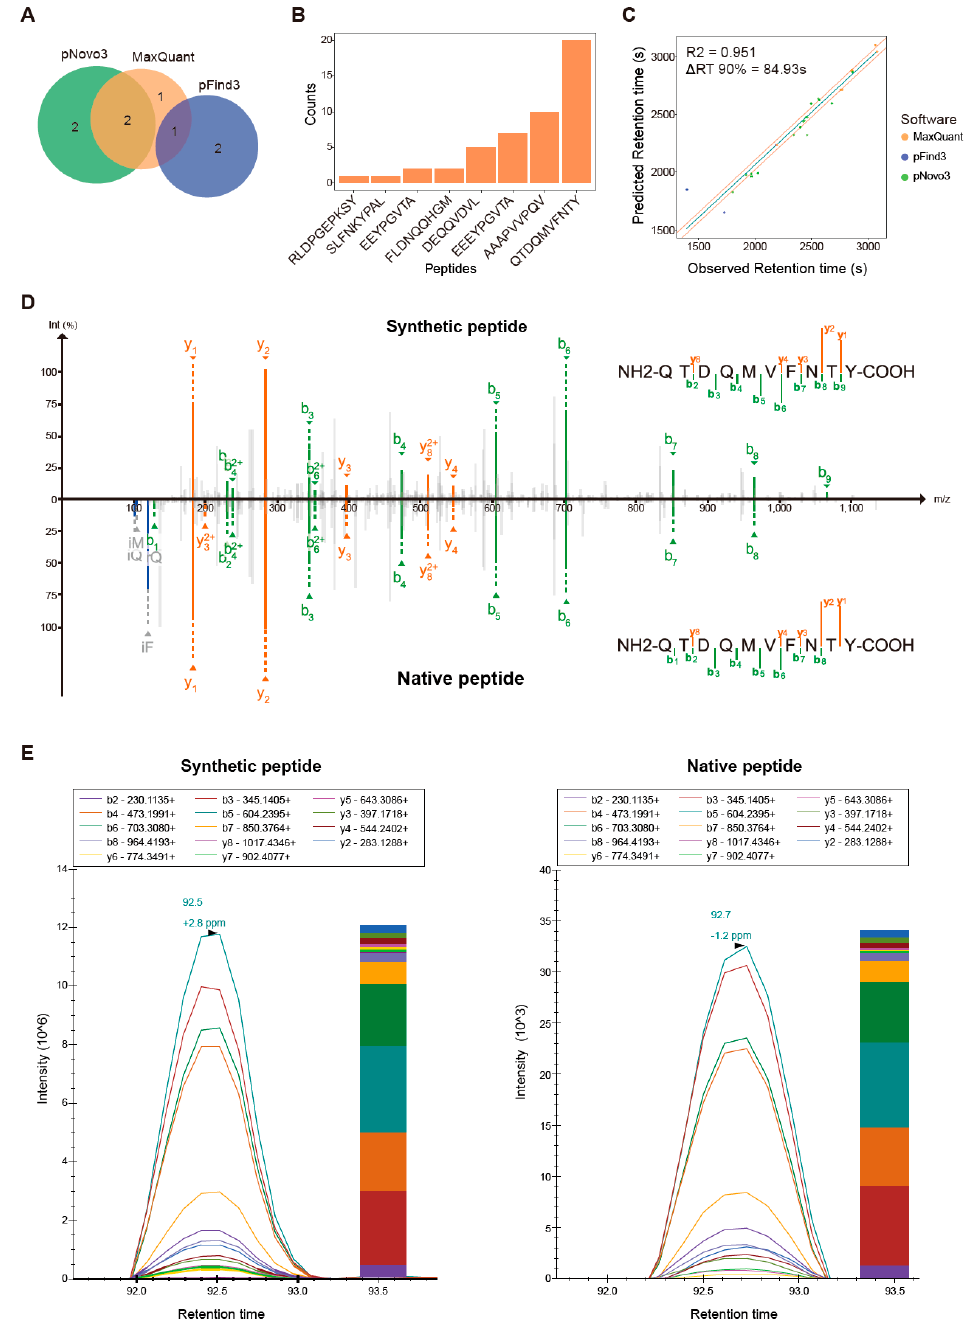
Figure 5. Features of tumor-specific neo-epitopes identified using an integrated proteogenomic ap- proach: ( A ) Venn diagrams showing the overlap in tumor-specific mutant peptides identified by three items of software; ( B ) Distribution of peptide-spectrum match (PSM) counts of eight tumor-specific mutant peptides; ( C ) Comparison of measured versus predicted retention times of eight mutant peptides; ( D ) Mirror diagram comparing the experimentally obtained mutant peptide spectrum (bottom) with its corresponding synthetic peptide spectrum (top) for mutant peptide QTDQMVFNTY; ( E ) Parallel reaction monitoring verifies the consistency of mutant peptides (right panel) with their corresponding synthetic equivalents (left panel) for mutant peptide QTDQMVFNTY. The intensity graph displays parallel reaction monitoring (PRM) peak signals of fragment ions. The bar graph shows the normalized peak areas of all fragment ions for the peptide. The contribution from each fragment ion is shown in a different color in the bar graph.